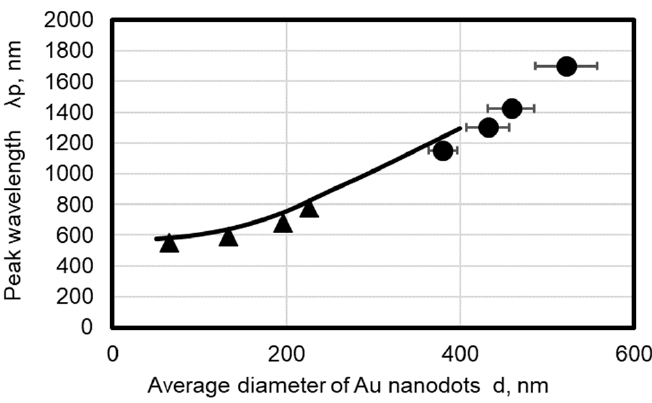
Figure 11. Change in peak wavelength against average dot diameter. ● : data obtained from Figure 10, ▲ : data referred from a previous report [32], curve: calculated date.